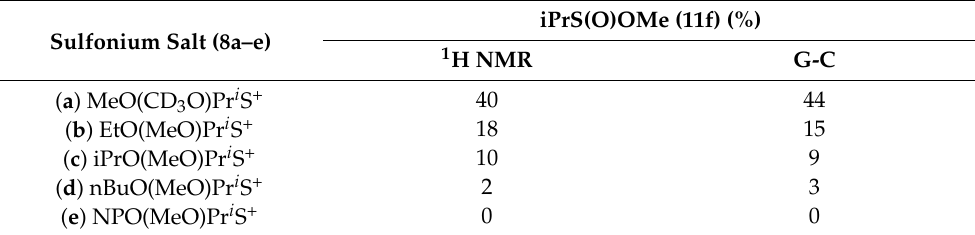
Table 2. Content of methyl isopropanesulfinate 11f in a mixture with alkyl isopropanesulfinates 11a – e .